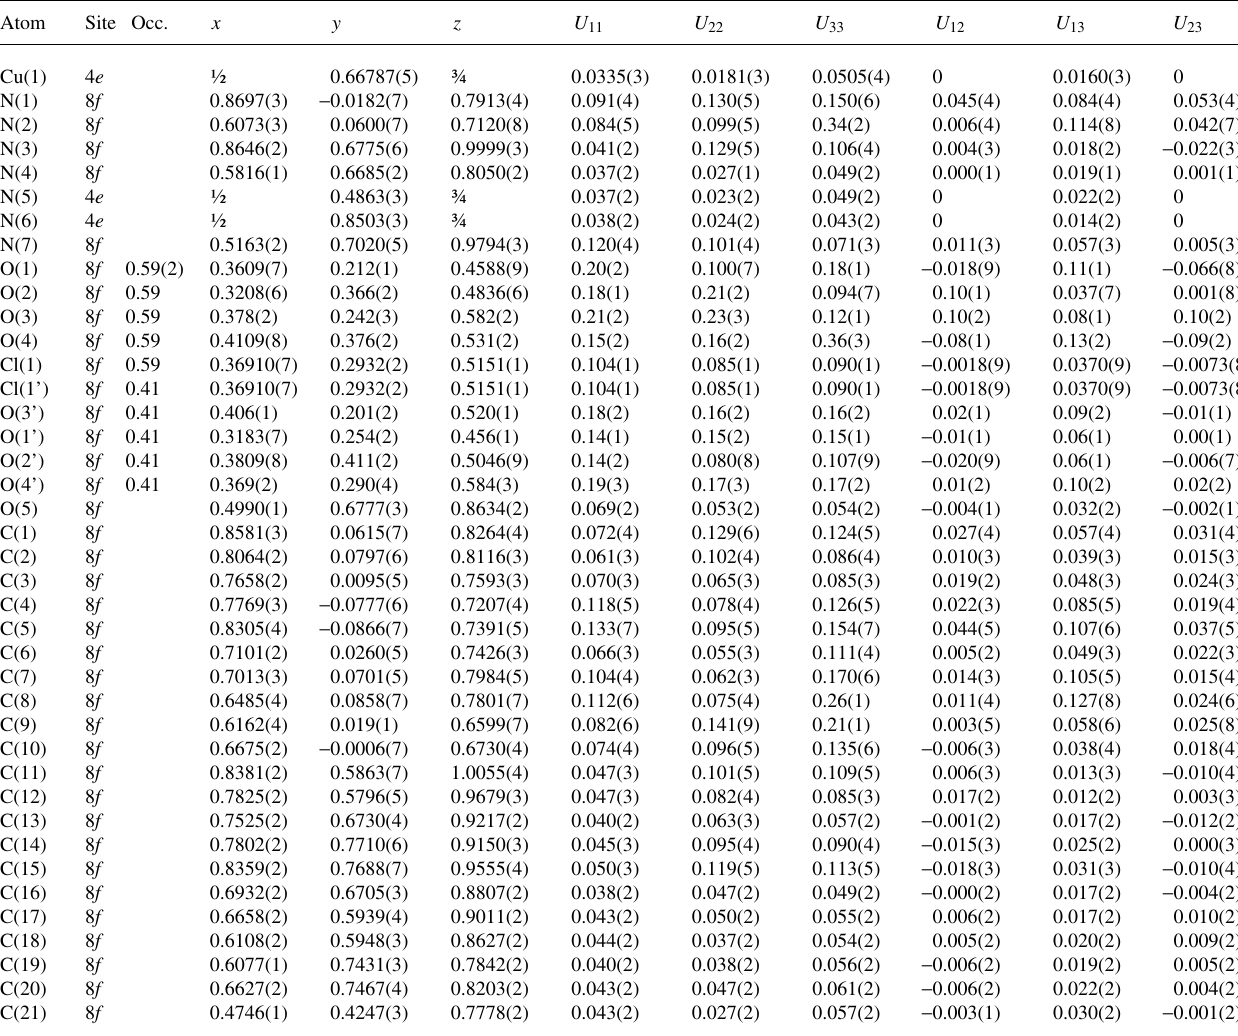
Table 3. Atomic coordinates and displacement parameters (in Å 2 ) .